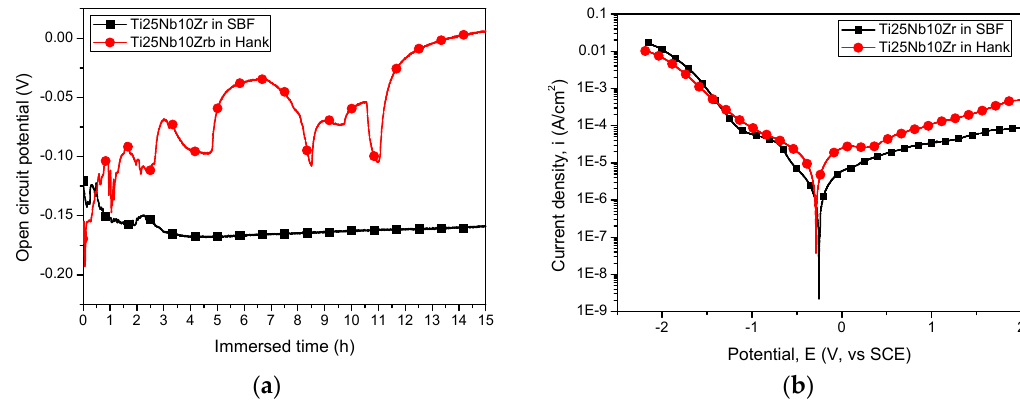
Figure 2. ( a ) Open circuit potential curves of Ti25Nb10Zr alloy in simulated body fluid (SBF) and Hank solutions (symbols are used only for identifying the curves in grey scale printing); ( b ) potentiodynamic polarization curves of Ti25Nb10Zr alloy in SBF and Hank solutions.